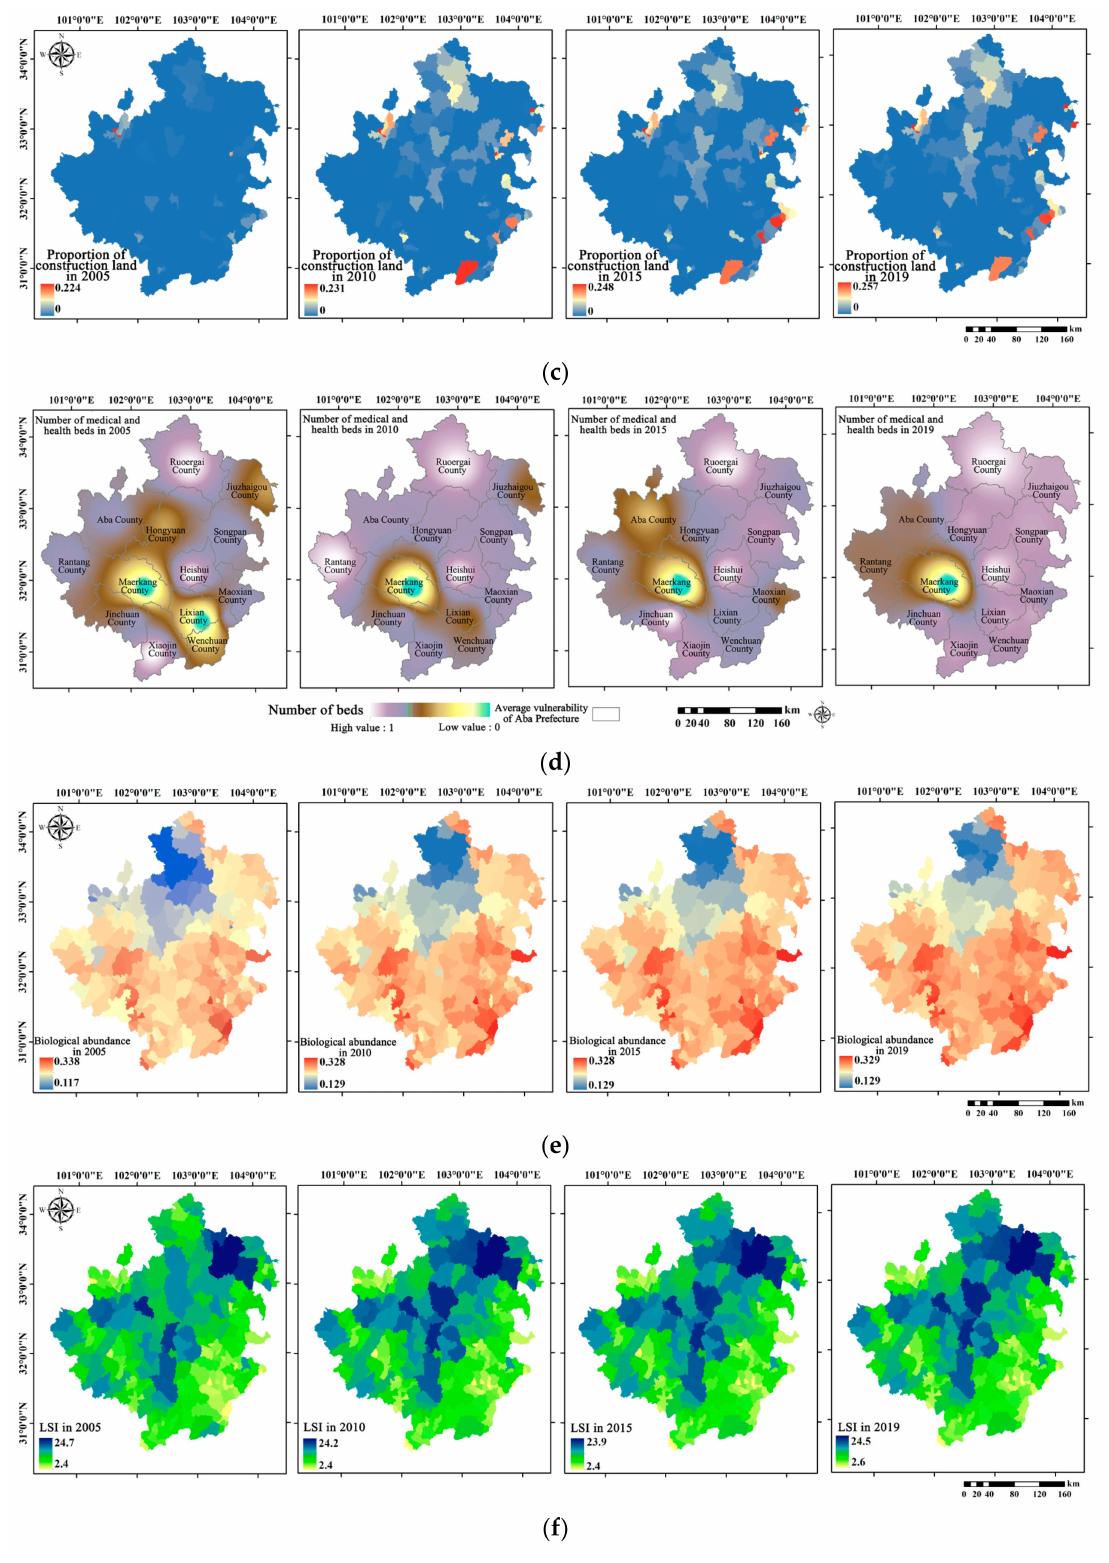
Figure 6. Spatial distribution map of adaptability indexes. ( a ) grain output per unit area, ( b ) FVC, ( c ) the proportion of construction land, ( d ) the number of beds in medical and health institutions per 1000 people, ( e ) biological abundance index, and ( f )